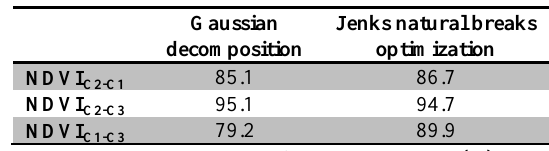
Table 8. Comparison of overall accuracies